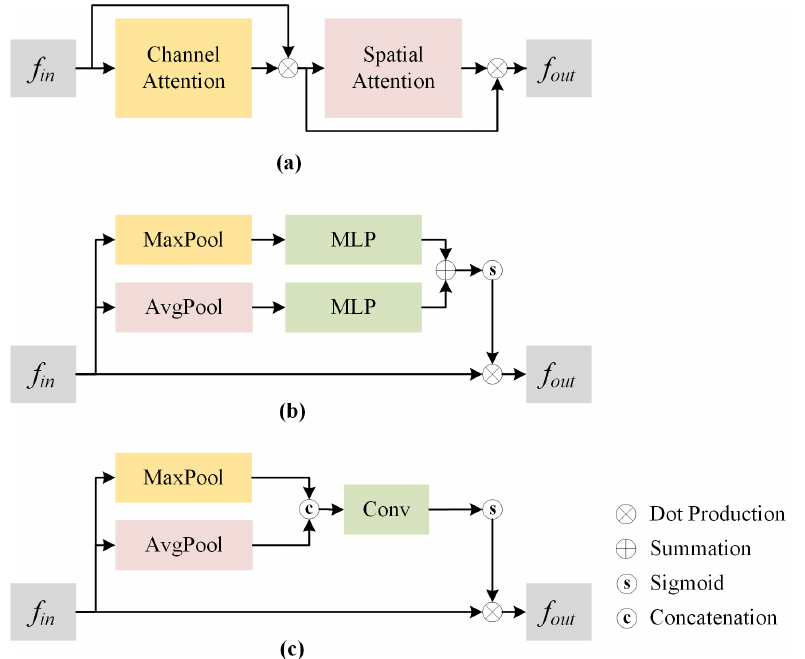
Figure 5. ( a ) The convolutional block attention module (CBAM). ( b ) The channel attention block. ( c ) The spatial attention